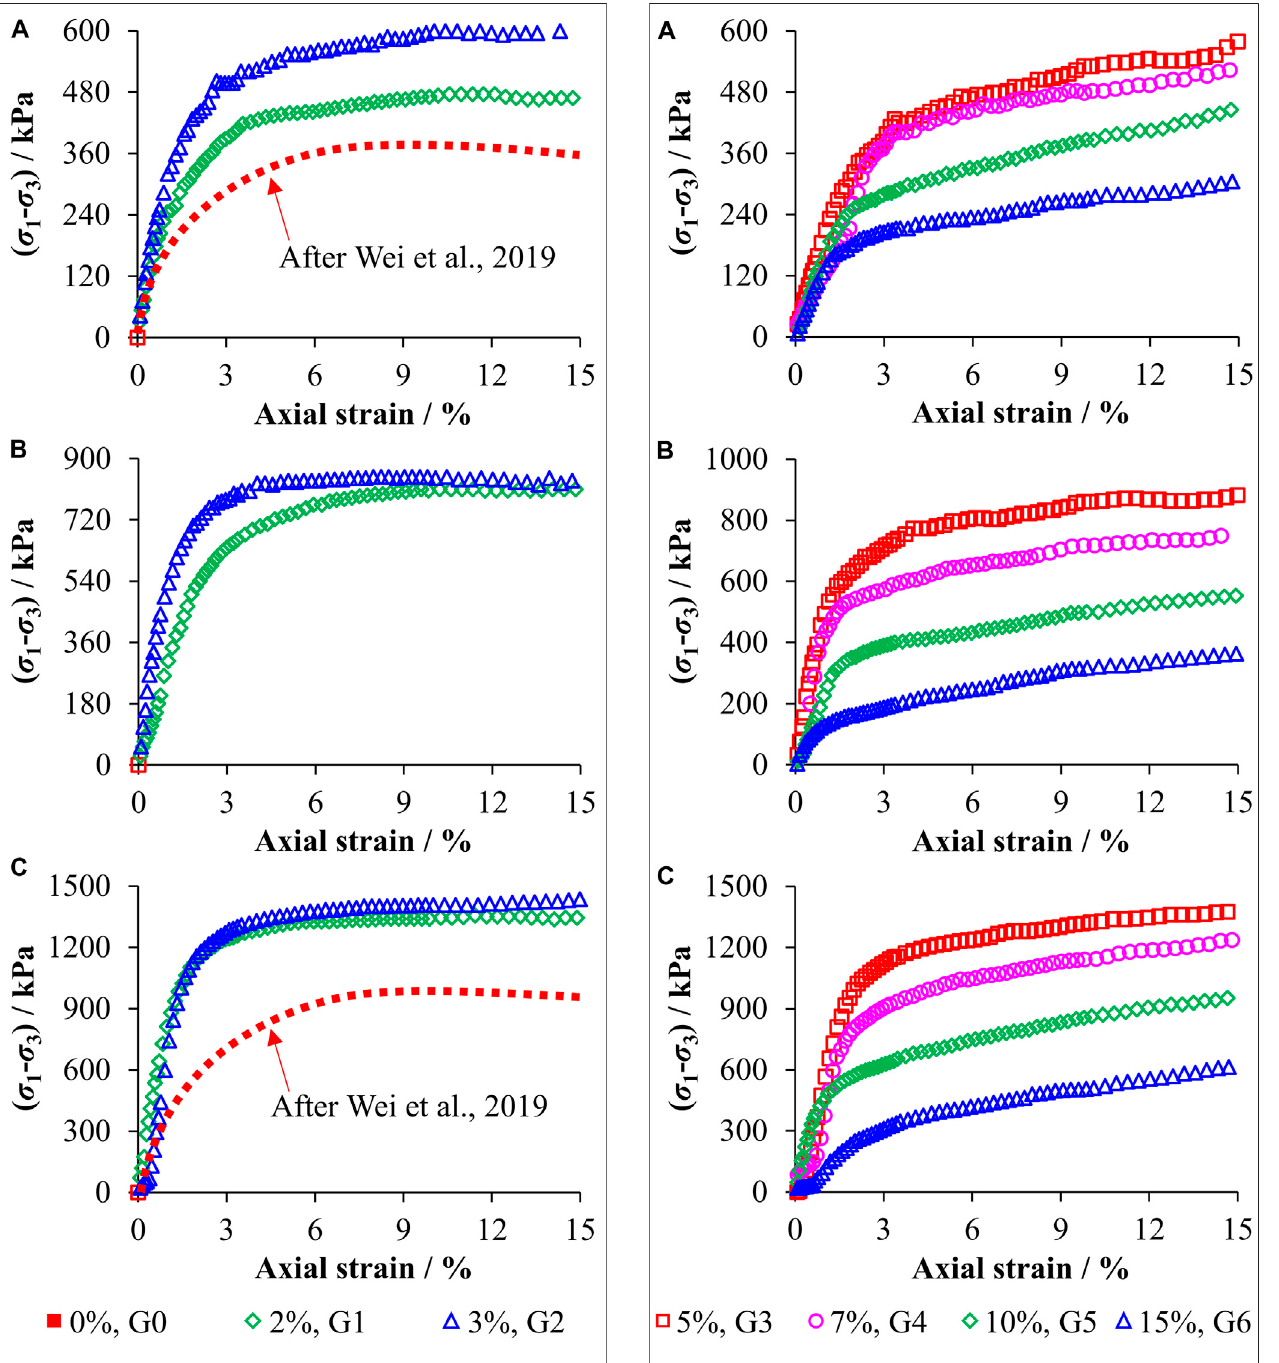
FIGURE 3 | Stress – strain responses of TCS with different amounts of silicapowder(theamountoffusedquartzisconstant)atcon fi ningpressuresof 50 (A) , 100 (B) , and 200 kPa (C) .